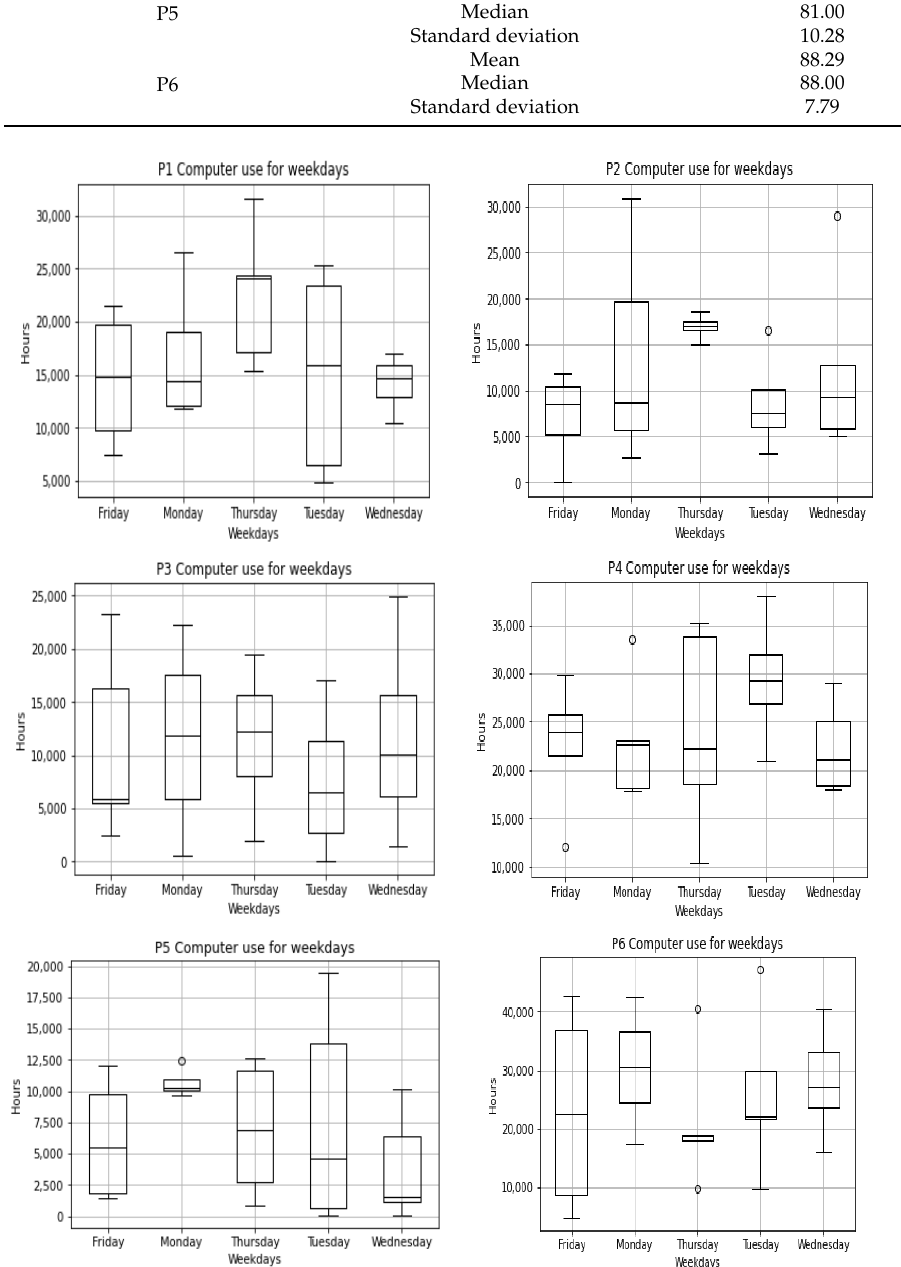
Figure 10. Weekday Computer Usage per Participant ( n =